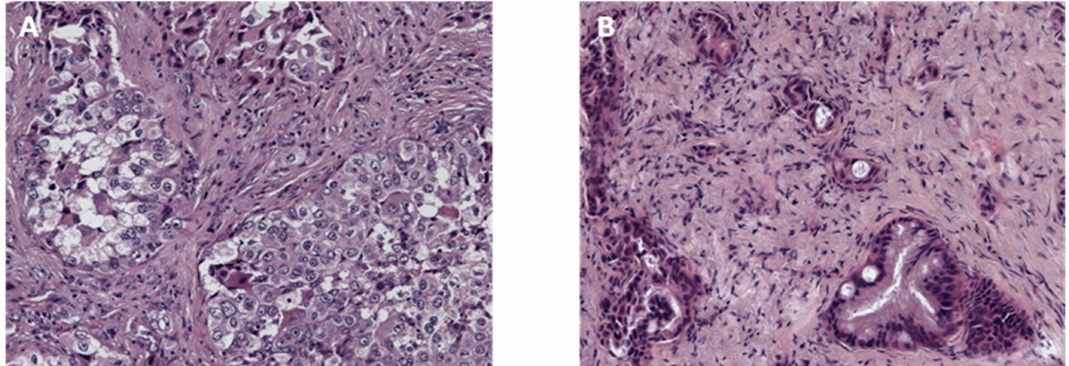
Figure 2. Histological presentation of the two primary tumors. ( A ) Lung adenocarcinoma in haematoxylin and eosin (20 × ) staining: solid growth aggregates of poorly di ff erentiated cells with large cytoplasm and bulky nucleus with irregular chromatin and nucleolus. ( B ) Pancreatic ductal adenocarcinoma in haematoxylin and eosin (20 × ) staining: irregular glandular mucinous aggregates (both large and small), immersed in a fibrous stroma, with basal-nucleus polarized cells and sporadic interposed goblet